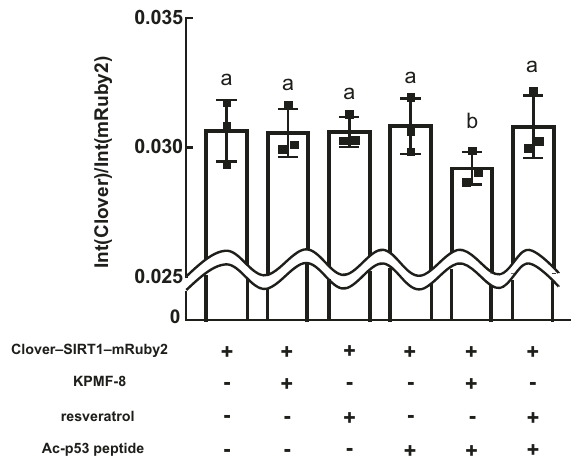
Fig. 8 FRET measurements of Clover – SIRT1 – mRuby2 in the absence or presence of KPMF-8, resveratrol and Ac-p53 peptide. Results are presented as the fl uorescent intensity ratio of mRuby2 to Clover (Mean ± SD, n = 3 independent experiments). Means with the same letter are not signi fi cantly different ( p < 0.05).